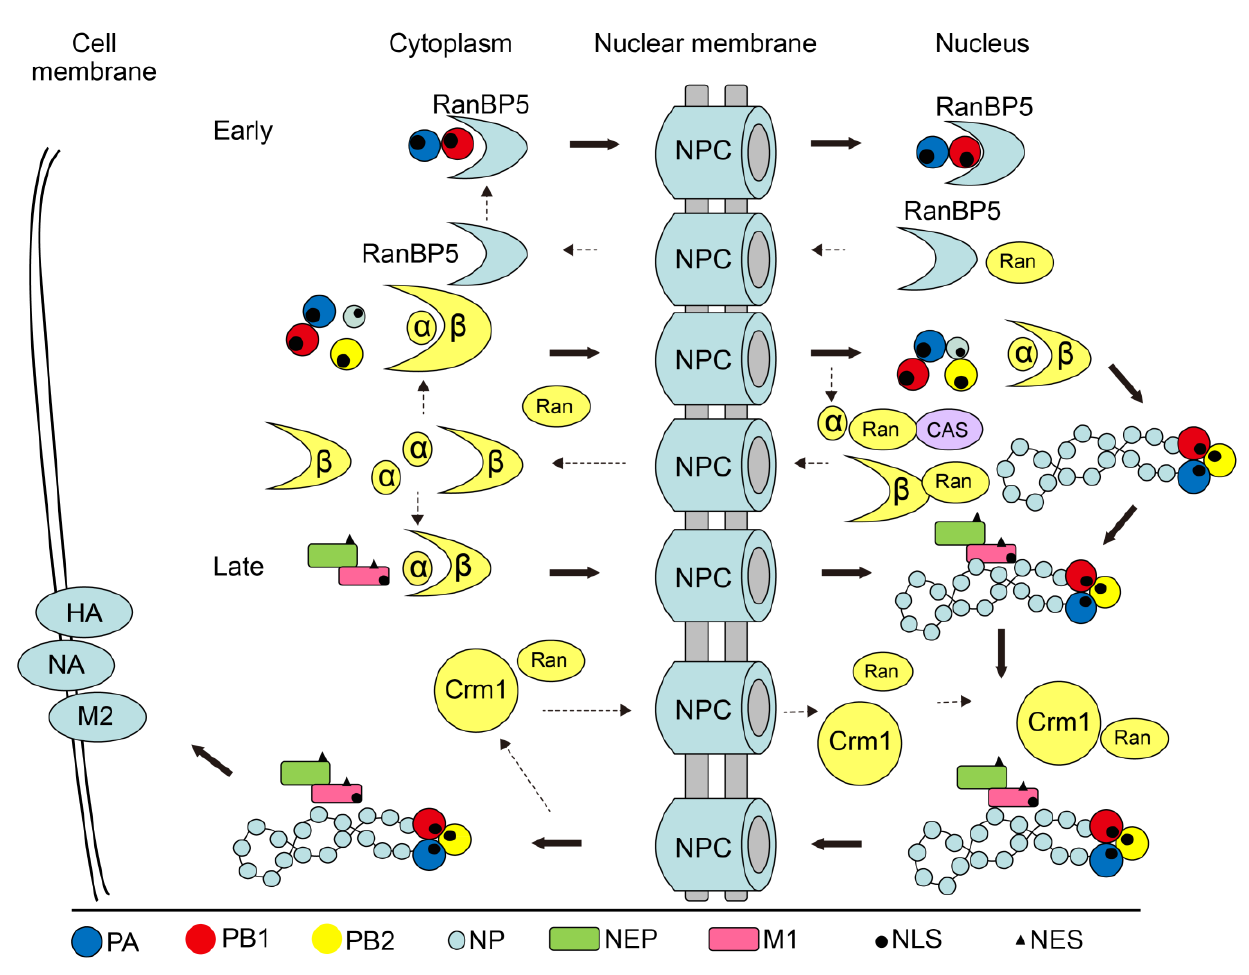
Figure 1. Model of the nucleocytoplasmic shuttling of influenza virus proteins and